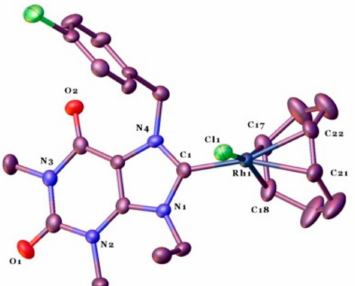
Figure 7. Molecular structure of compound 22 . Thermal ellipsoids are drawn at the 50% level. Hydrogen atoms have been omitted for